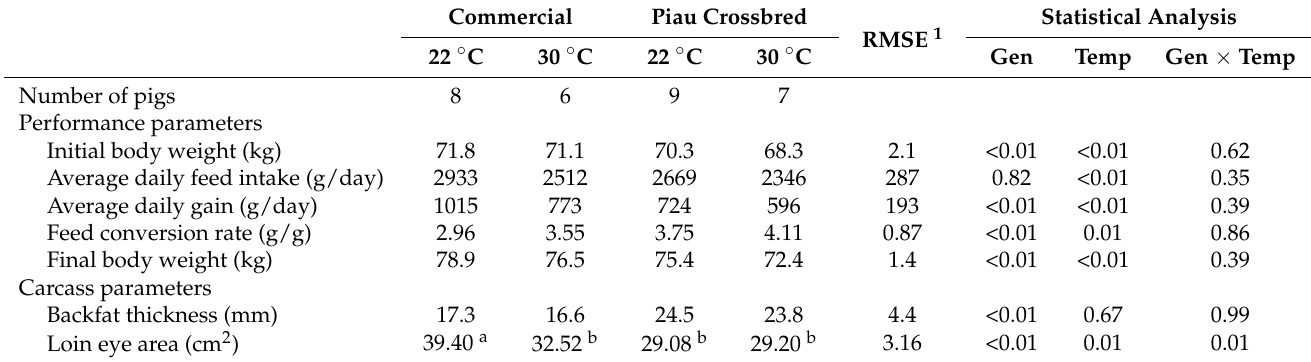
Table 1. Ambient temperature effects on performance and carcass parameters of commercial and crossbred (Brazilian Piau purebred sires × commercial dams)